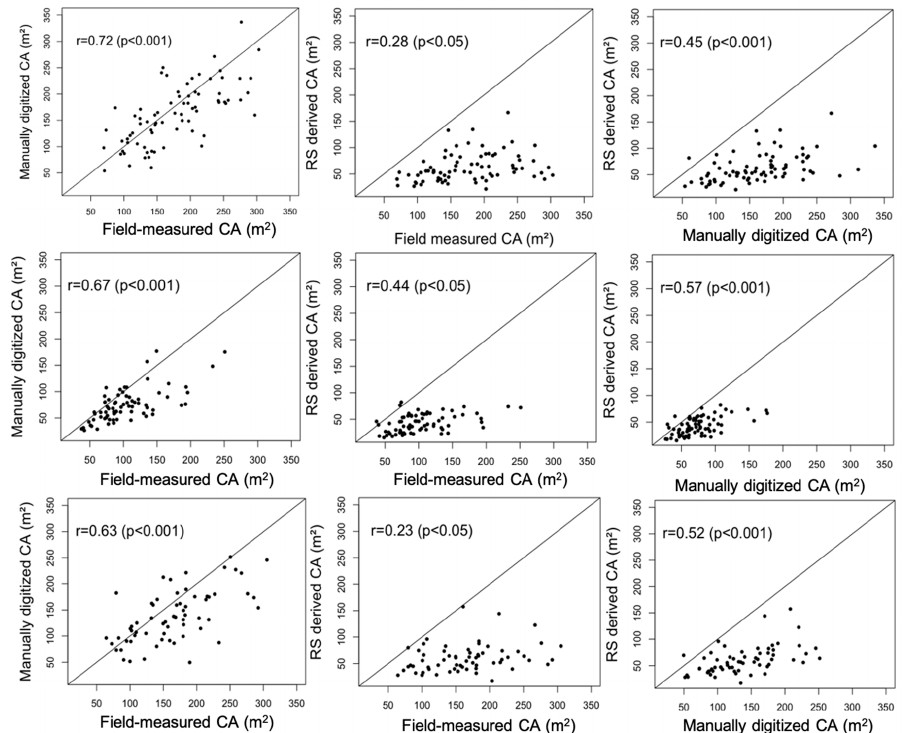
Figure 2. Correlations between crown areas derived from field measurements, manual delineation, and multiresolution segmentation of UAV orthophotographs. CA represents crown area. The first, second, and third row represent monarch birch, castor aralia, and Japanese oak, respectively. RS-derived CA represents CA derived from multiresolution segmentation. Remote Sens. 2020 , 12 , x FOR PEER REVIEW